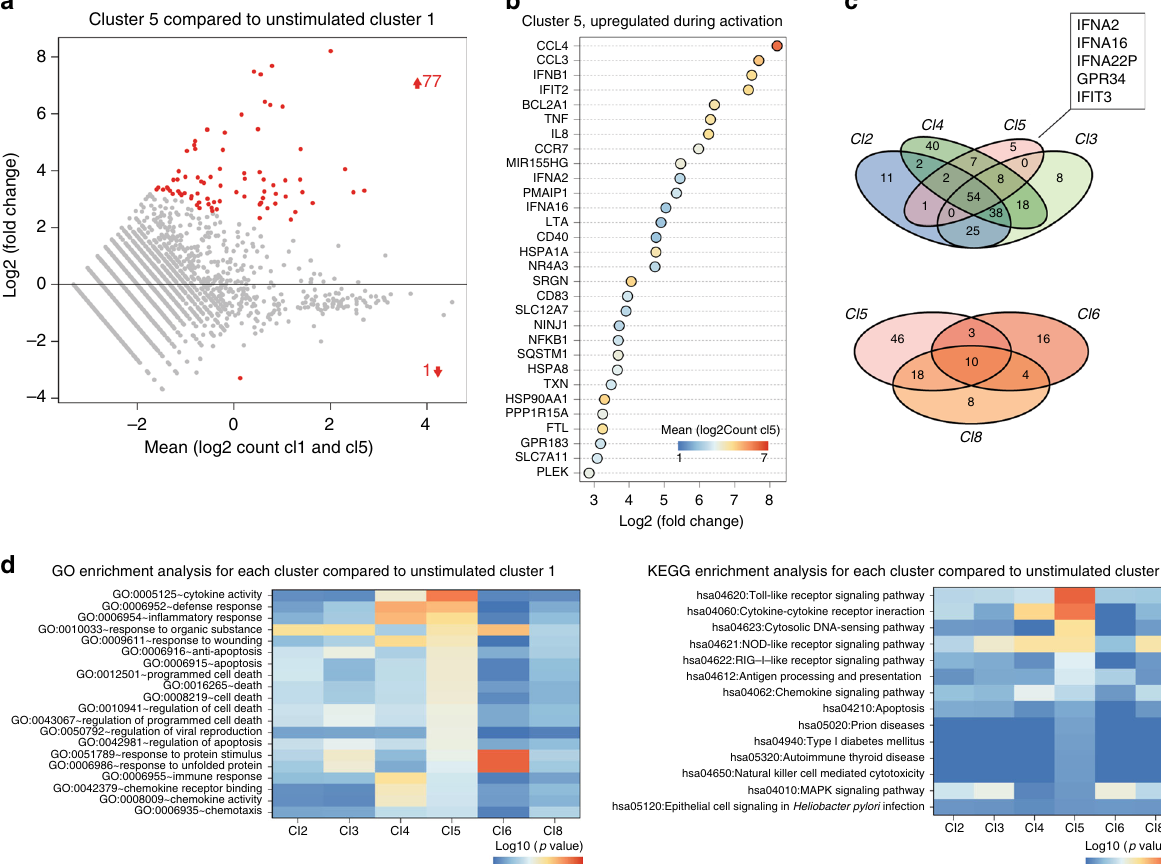
Fig. 4 Type I IFN-expressing pDCs show unique gene expression patterns. a Differentially regulated genes in cells from all activated clusters compared to cluster 1 were identi fi ed. Differentially regulated genes from cluster 5. The average log2(count) of each gene is plotted against the log2(fold change) compared to cells in Cl1. Red color indicates p value < 10 − 8 . b The top 30 most upregulated genes are shown for cluster 5. Shown is the log2 fold change for each gene. The color scale indicates the average log2(Count) for each transcript in Cl5. c Venn diagram of the upregulated genes (log2(fold change) > 1.5, p value < 10 − 8 ) within different clusters. d Lists of upregulated genes were submitted to DAVID for GO enrichment analysis and KEGG enrichment analysis. Heat maps show the most signi fi cantly enriched terms for the gene list from cluster 5. The color scale indicates the signi fi cance of enrichment of a particular term in all selected clusters after Benjamini – Hochberg correction for multiple